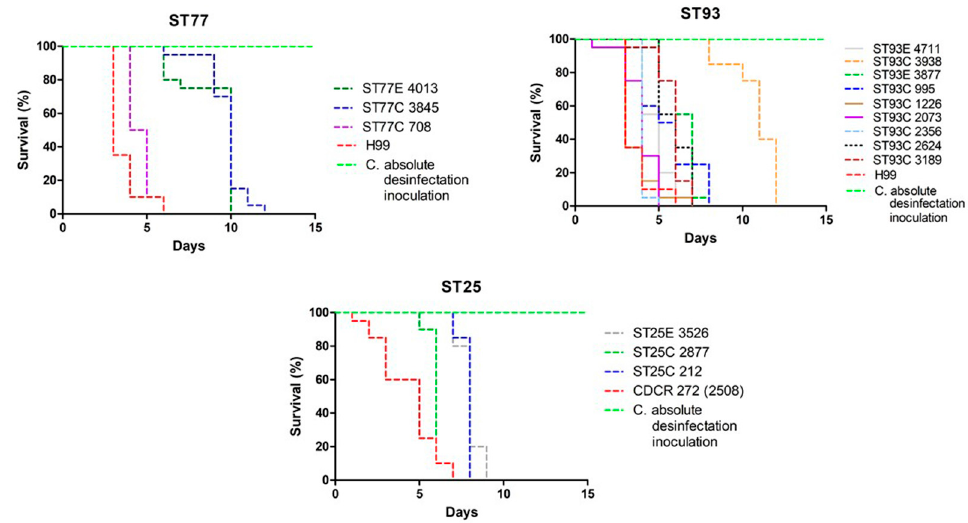
Figure 2. Survival curves of G. mellonella inoculated with Colombian isolates of the C. neoformans species complex (ST77 and ST93) and C. gattii species complex (ST25).